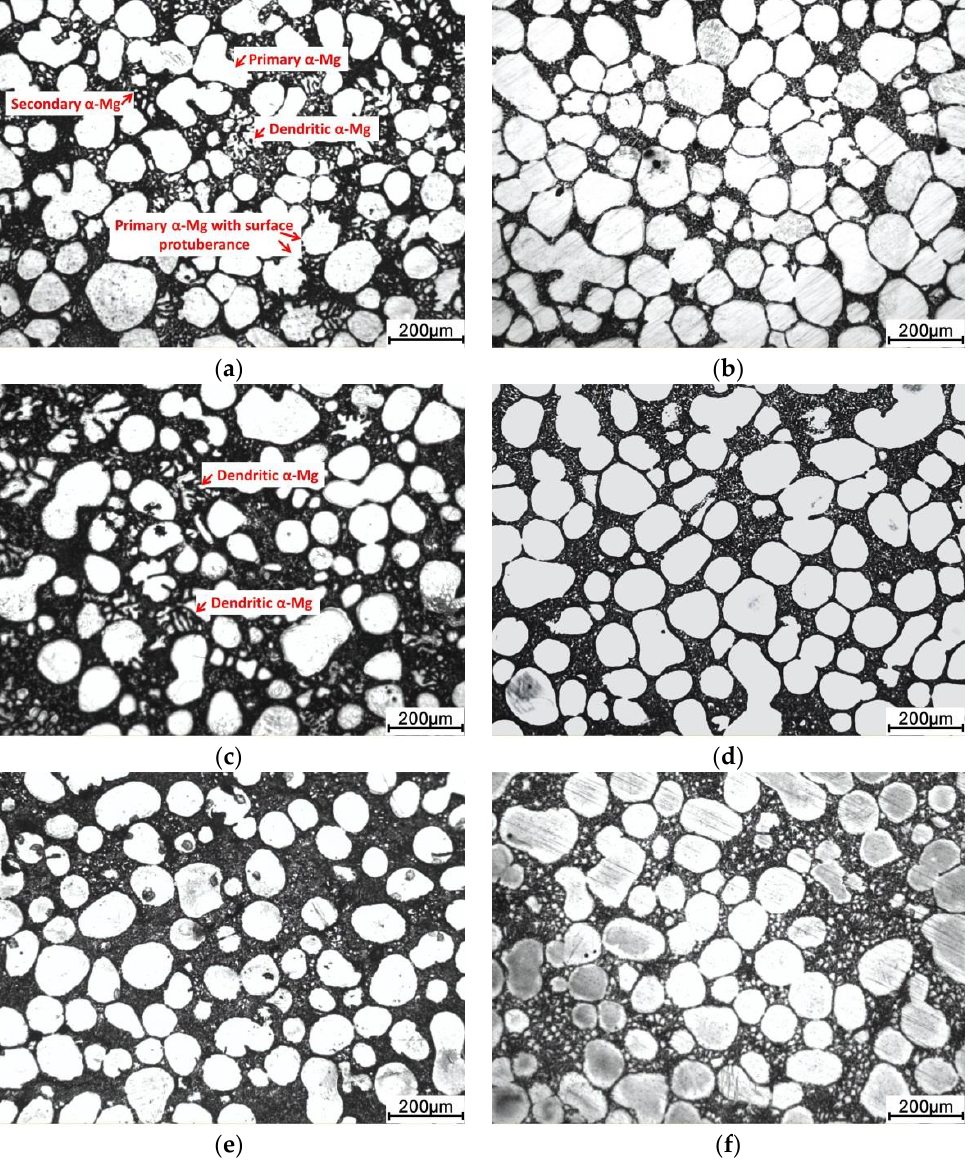
Figure 5. Microstructure of the rheo-diecast AZ31 alloy with different solid fractions of 42% ( a , c , e ) and 61% ( b , d , f ) under different injection velocities. ( a , b ) 0.5 m/s; ( c , d ) 1 m/s; ( e , f ) 3 m/s.